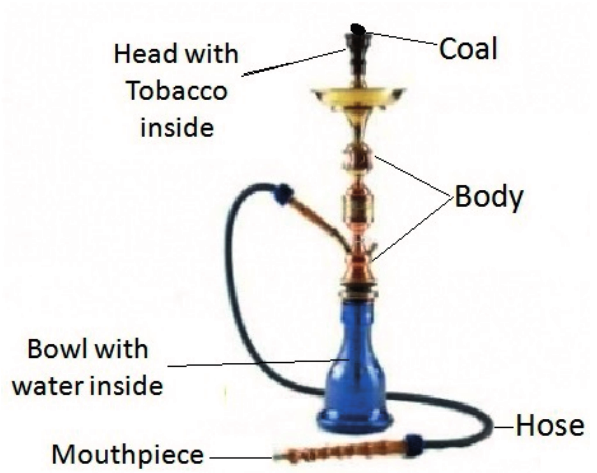
Figure 1. The structure of a waterpipe